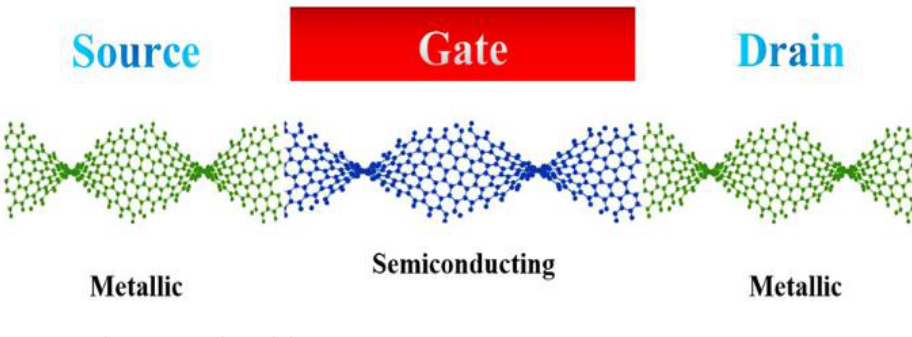
Figure 2. The proposed